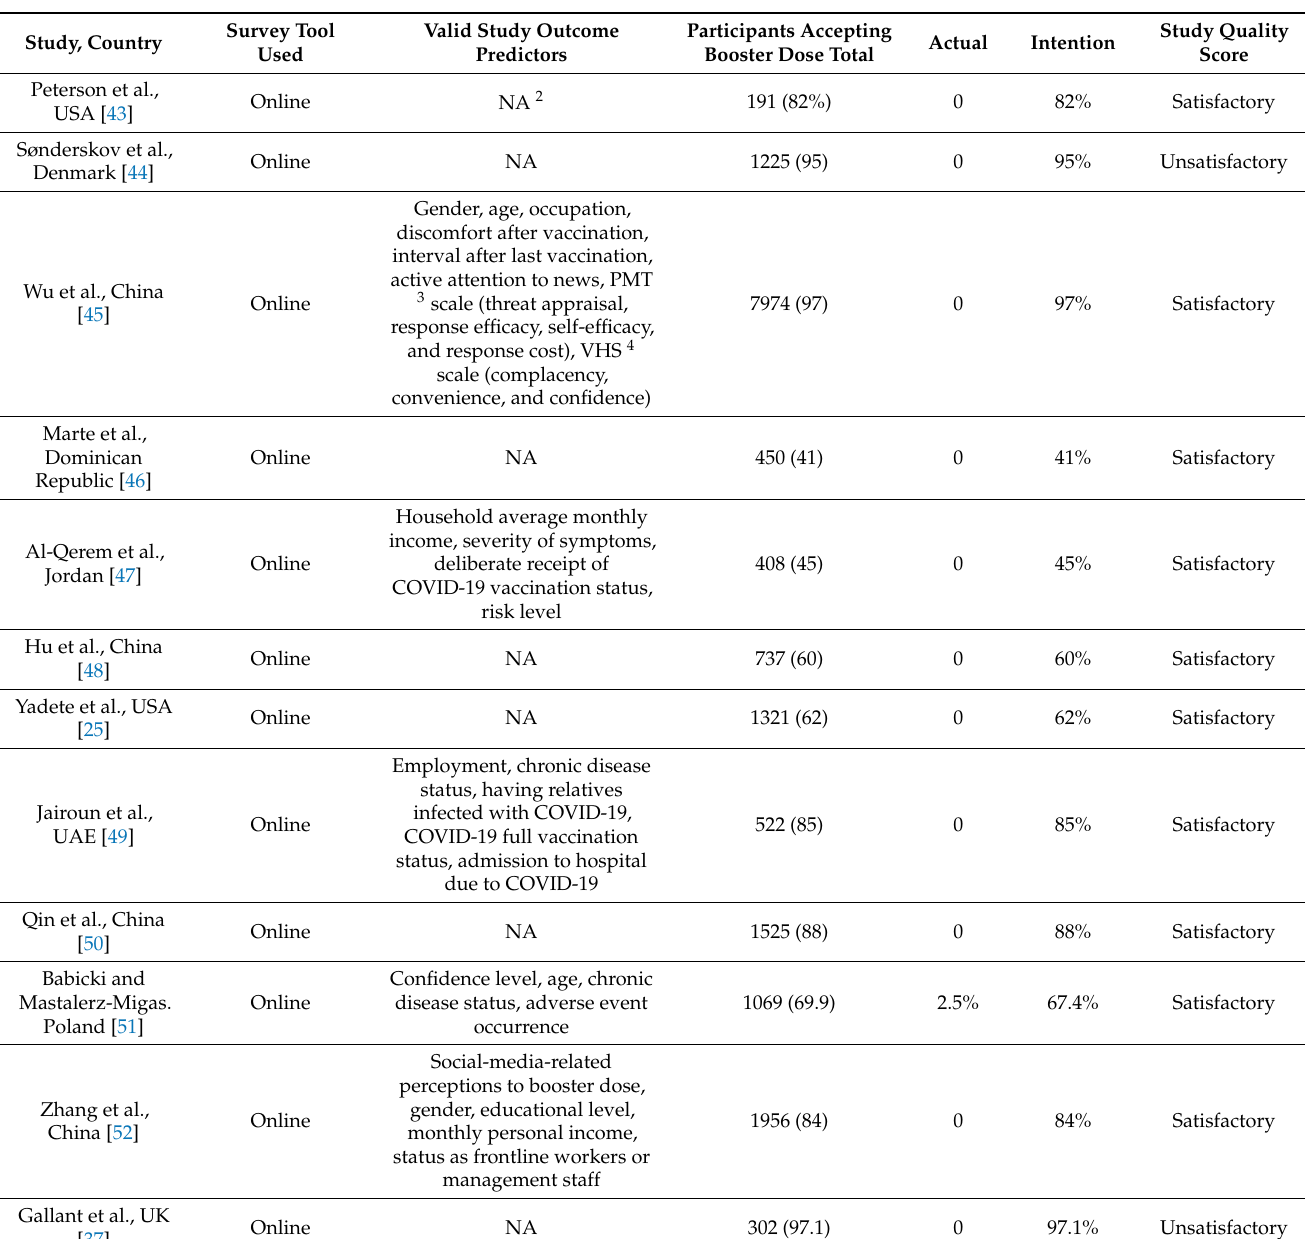
Table 2. Intention to receive booster COVID-19 vaccination and its predictors in the included